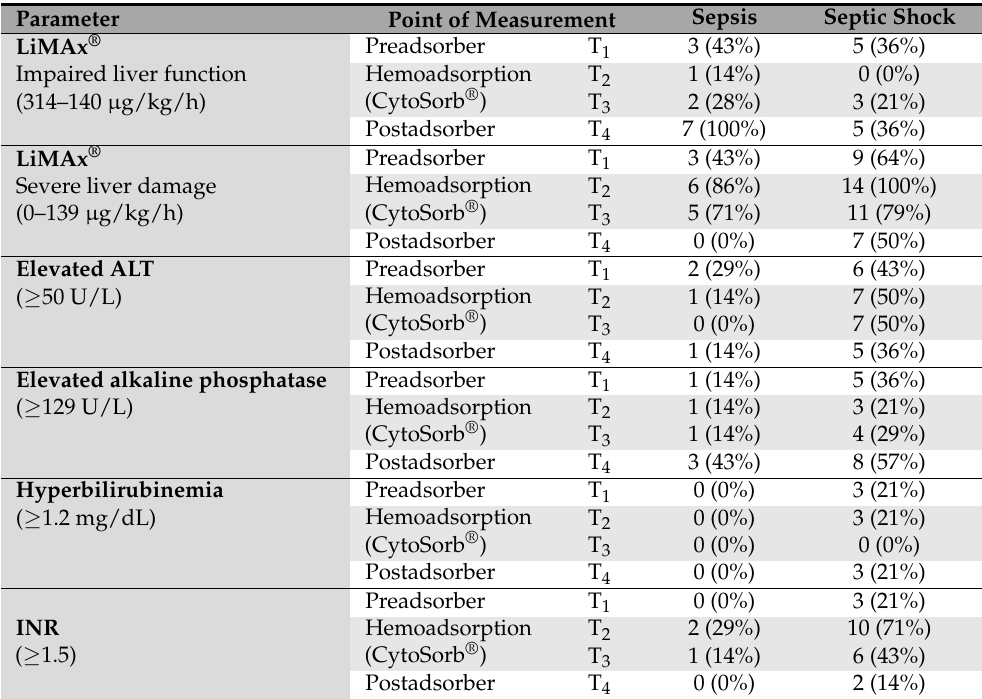
Table 3. Hepatic impairment or liver failure in sepsis and septic shock. Parameter Point of Measurement Sepsis Septic Shock LiMAx ® Preadsorber T 1 Impaired liver function